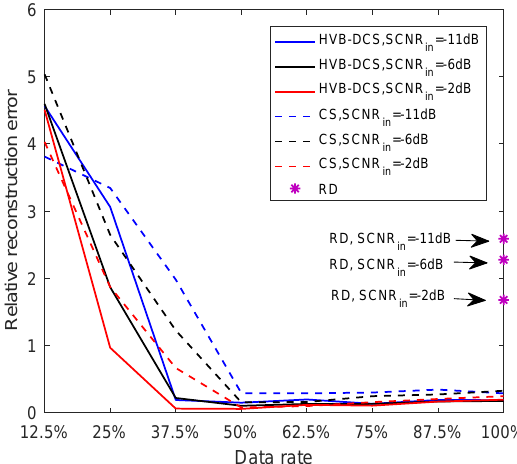
Figure 15. Reconstruction errors of three algorithms, i.e., RD, CS and HVB-DCS algorithms, based GMTI system for the varying data rates in azimuth and different SCNR in